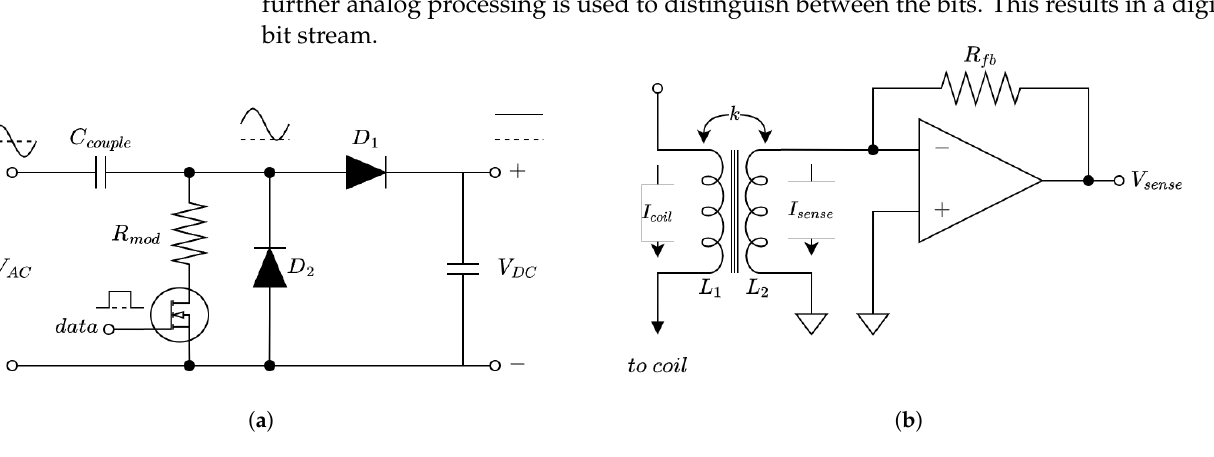
Figure 11. ( a ) Rectifier and load modulator. ( b ) Current-sensing